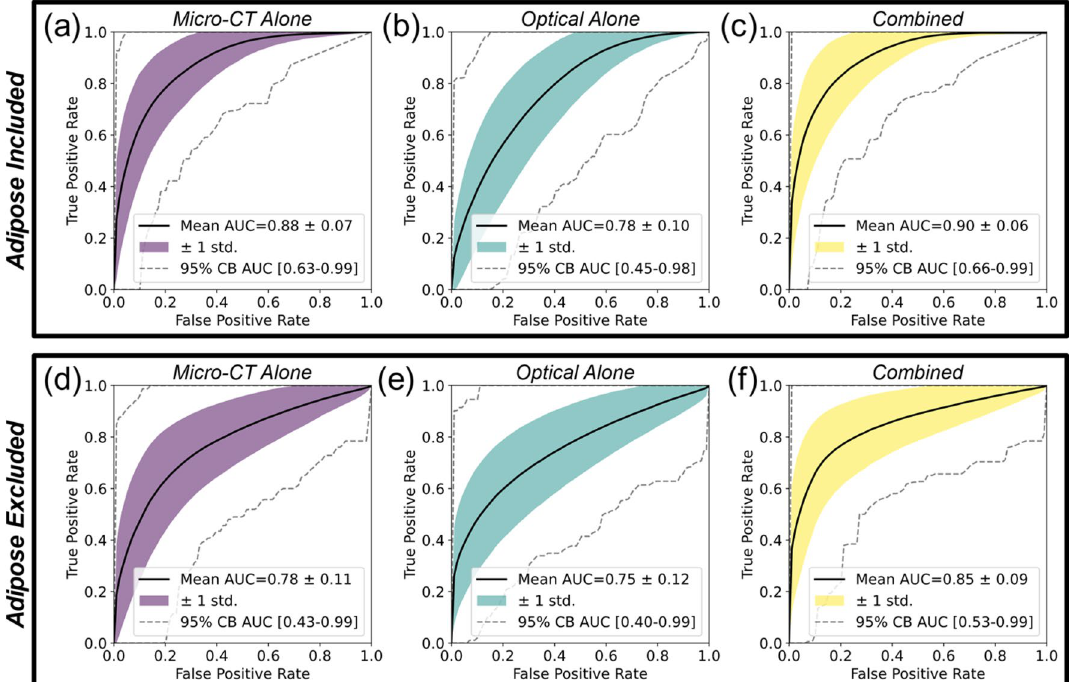
Figure 2. ROC curve analysis based on six radiomic/optomic features derived from 5 × 5 mm sub-image samples. Adipose tissue was included (top row) and excluded (bottom row). Each shaded region depicts two- dimensional one standard deviation from the mean ROC curve (solid black). AUC 95% confidence bands (CBs) contain 95% of the n = 1000 ROC curves that fell closest to the mean curve in each subplot (dashed black).